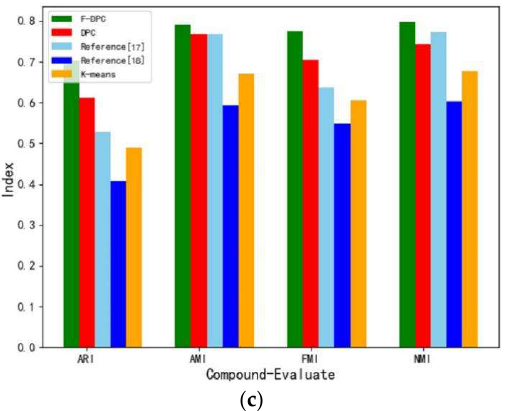
( c ) Figure 13. Clustering evaluation metrics for different datasets. Figure 13. Clustering evaluation metrics for different datasets [17,18]. ( a ) Jain-Evaluate. ( b ) Unbalance-Evaluate. ( c ) Compound-Evaluate.